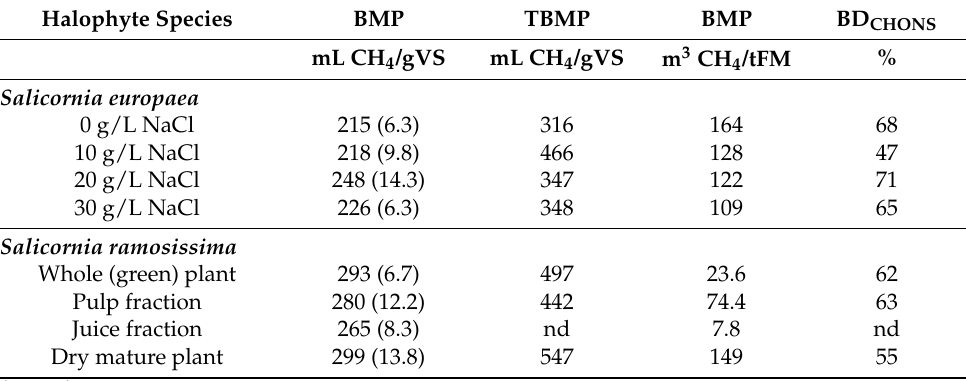
Table 5. Experimental BMP, TBMP and BD CHONS of Salicornia samples in mL CH 4 /gVS, m 3 CH 4 /tFM and %, standard deviation of triplicates in